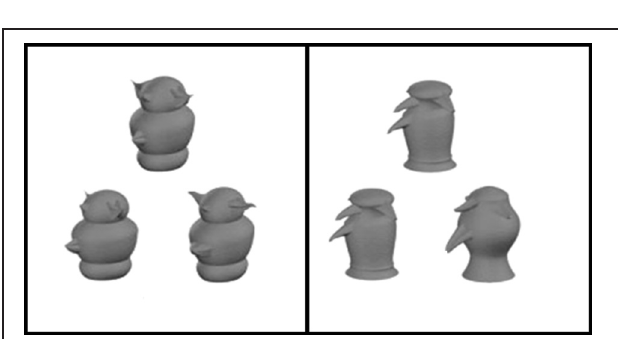
FIGURE 10 | Novel objects (greebles) used by Barense and colleagues (2010b). Participants were told that of the three pictues presented per trial, two depicted the same object, whereas the third picture was of a different object. They were instructed to select the different stimulus. In the difficult condition, the two matching objects were shown from two different viewpoints, while in the easier condition (right panel) the matching objects were shown from the same viewpoint (adapted from Barense et al.,